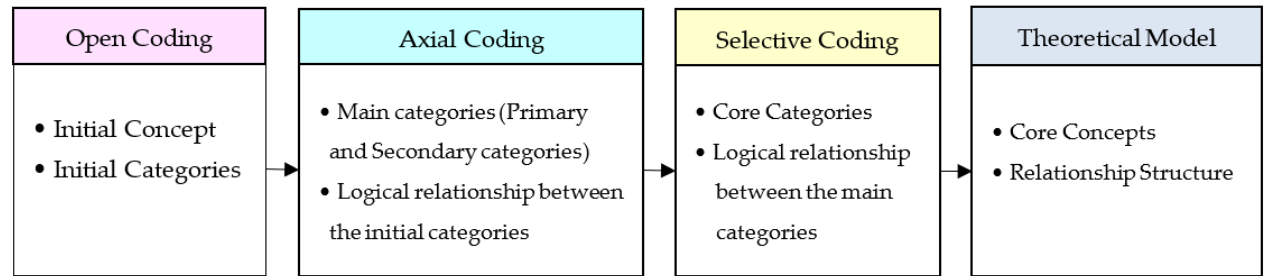
Figure 2. The logical relationship between the three codes and the research